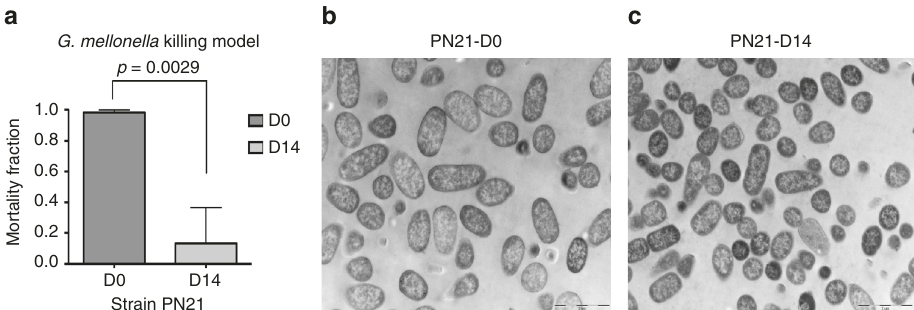
Fig. 8 G. mellonella killing data and TEM micrographs of strain PN21. a G.mellonella mortality rate in PN21 parental strain (D0) and its mutant (D14). Error bars represent the SD ( n = 3) and p value was calculated by Student ’ s t test ( t = 6.509, d.f = 4). b and c indicated TEM micrographs of parental strain PN21 (D0) and PN21(D14) mutant, respectively. Membranes for both strains are intact with a highly homogeneous electron density in